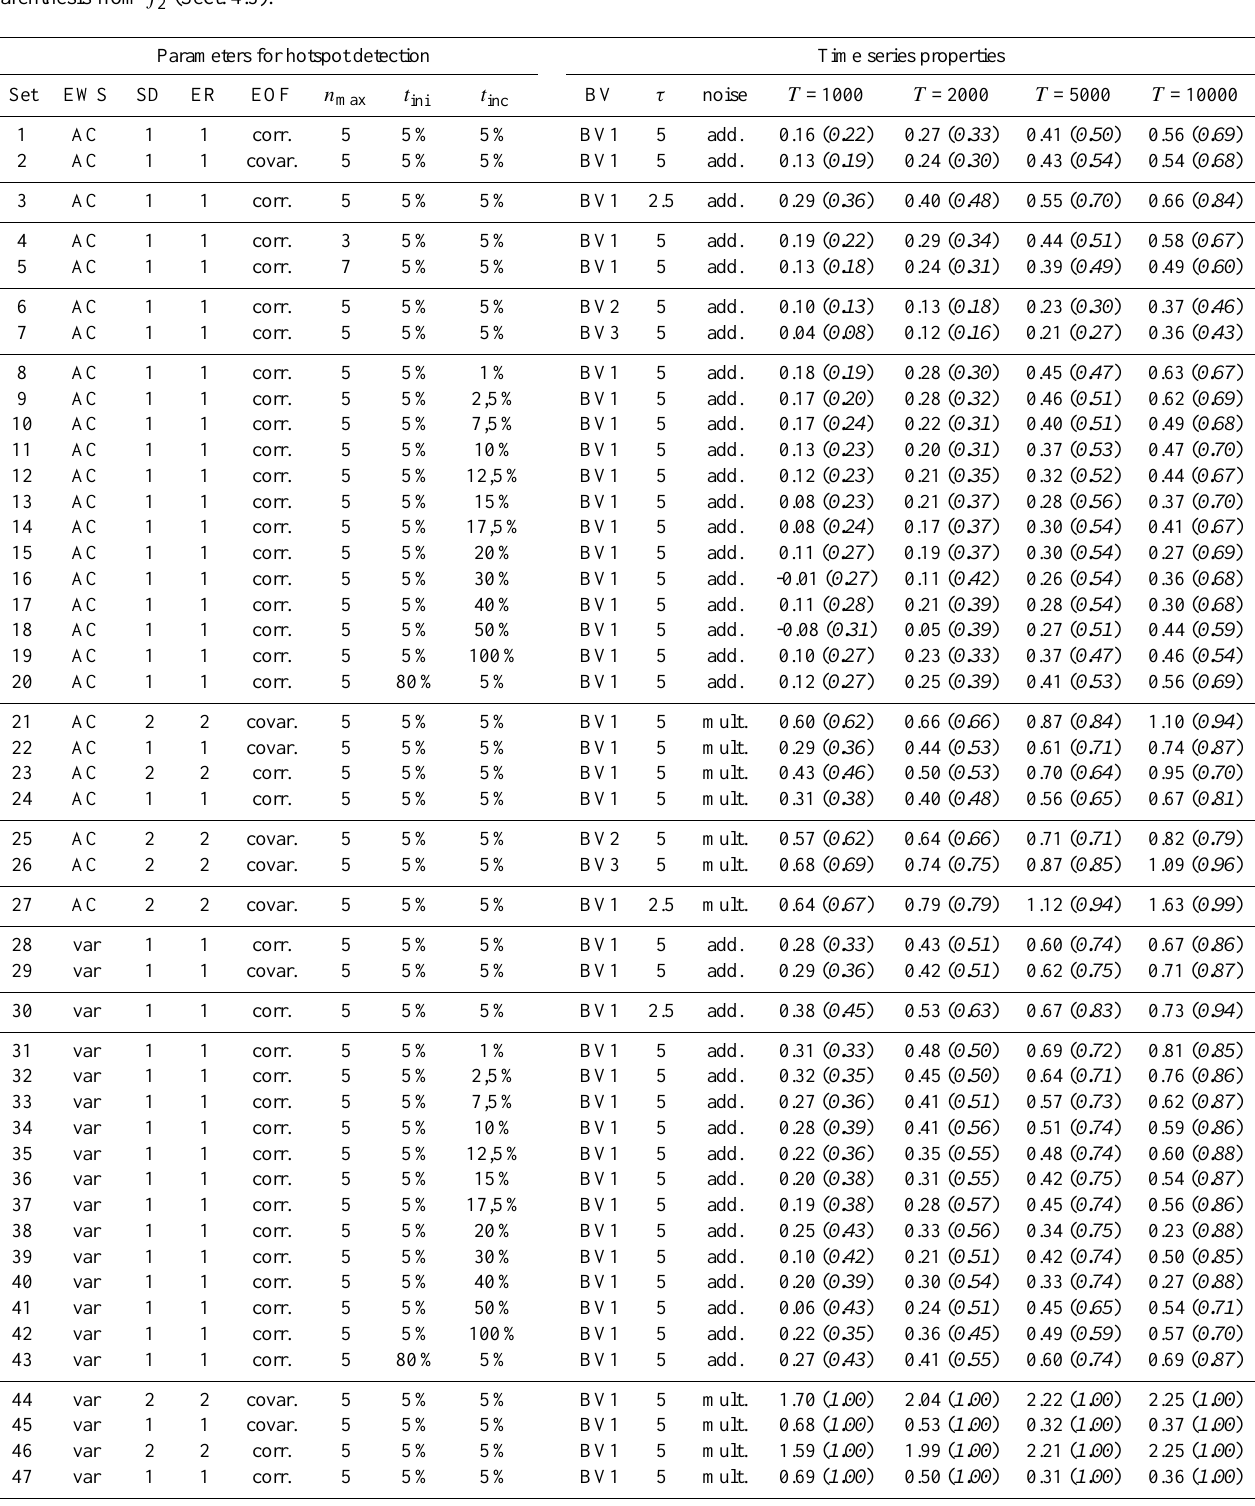
Table 4. Performances of the hotspot detection algorithm for different sets of versions, parameter choices and time series properties. SD=signal definition, ER=elimination rule, BV=vector of forcings B j . Performances are calculated from fractions f 1 , italic results in parenthesis from f 2 (Sect.